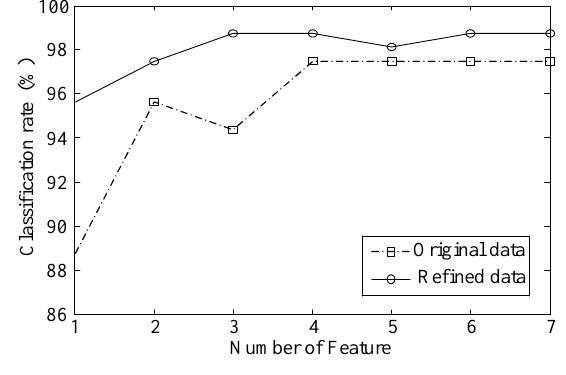
Figure 8. Classification rates for different number of